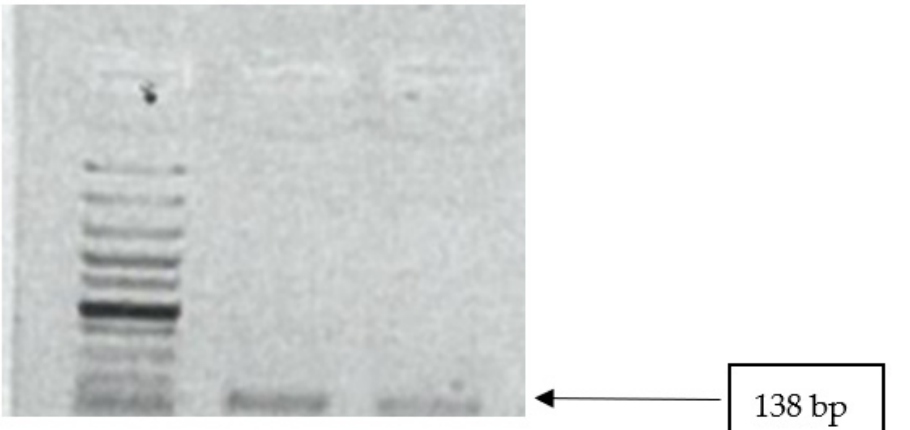
Figure 3. Image showing mecC gene amplicons observed on agarose gel. Lane 1: 100 bp DNA ladder; lanes 2–3 show positive band for mecC genes (138 bp).